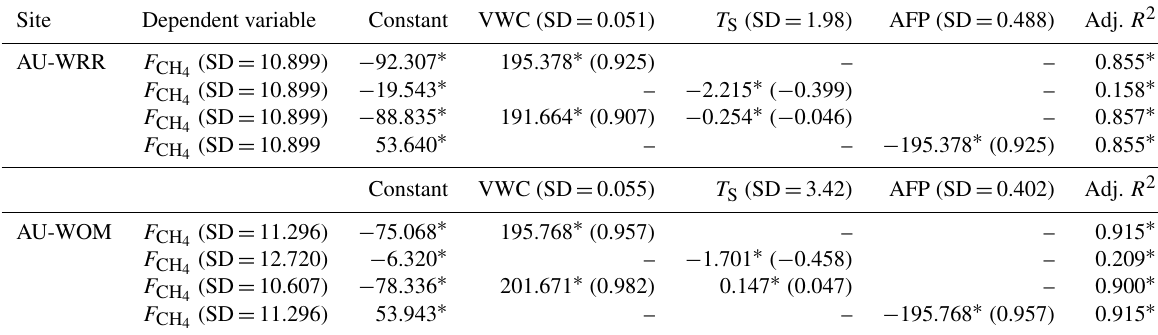
Table 1. Parameters and coefficients of determination (Adj. R 2 is adjusted R-squared) of linear regression models explaining seasonal ) at a mixed Eucalyptus obliqua forest stand, Wombat State Forest, Victoria (AU- variability in mean chamber cycle methane flux ( F CH 4 WOM) and at a mixed E. obliqua and E. regnans forest stand, Warra LTER, Tasmania, Australia (AU-WRR). Standardised coefficients β are in parentheses. SD refers to standard deviation of parameter; level of significance ( ∗ p ≥ 0 . 001). Predictors: T S (soil temperature), AFP (air-filled porosity) and soil VWC (volumetric water content). Presented constants are model intercepts and parameters represent the slopes for the predictor